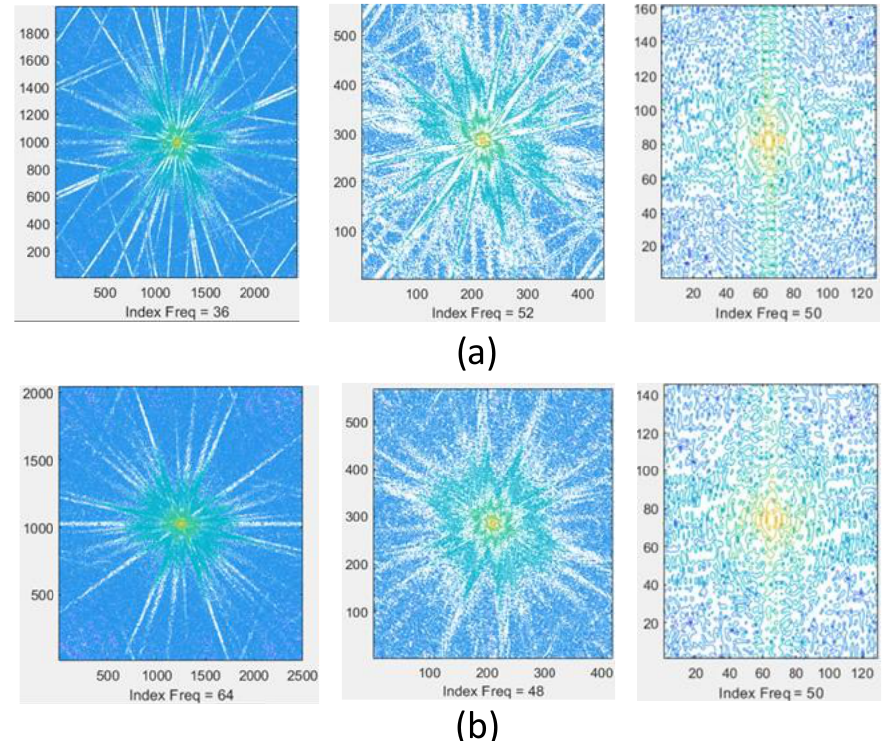
Figure 4. Frequency index of different image data of pelvic (left), hip (middle), and lumbar spine (right); ( a ) normal bone and ( b ) osteoporotic bone, where the color is indicating the intensity of frequency.